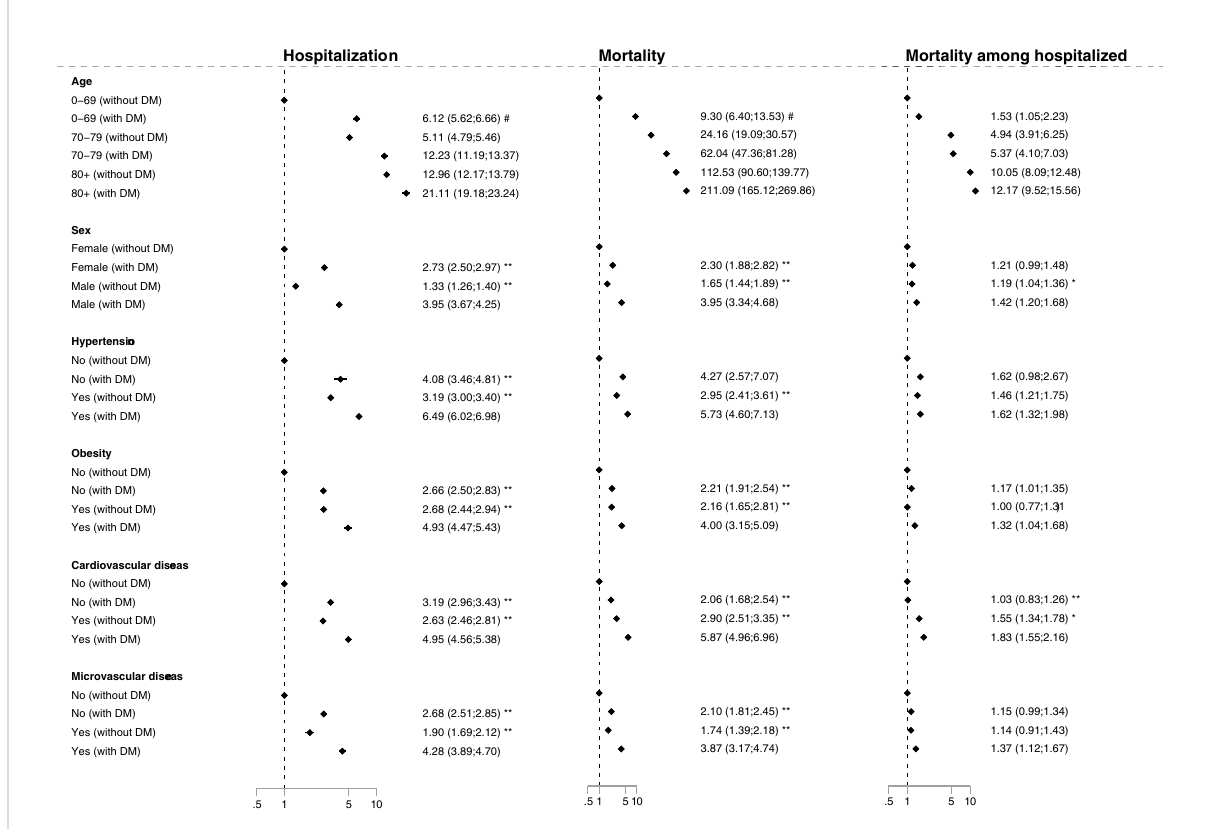
FIGURE 2 Forest plot of hazard ratios for the primary outcomes in persons with diabetes compared to persons without diabetes for strati fi ed groups in wave 2, adjusted for age and sex. Mortality was de fi ned as death within 30 days of the start of a COVID-19 related hospitalization, which was de fi ned as hospitalization for more than 12 hours within 30 days prior and 14 days after a positive test for SARS-CoV-2 and with a recorded COVID-19 diagnosis for the hospital contact. Reference for the hazard ratio for the strati fi ed groups were: 0-69 year without diabetes; females without diabetes; persons with neither hypertension nor diabetes; persons with neither obesity nor diabetes; persons with neither microvascular disease nor diabetes; persons with neither cardiovascular disease or diabetes, respectively. In addition the difference in HR was tested versus males with diabetes, hypertension with diabetes, obesity with diabetes, cardiovascular disease with diabetes, microvascular disease with diabetes, respectively: *p<0.05, **p<0.001. Difference in the risk between (the many) age groups and diabetes were tested overall by interaction analysis: #